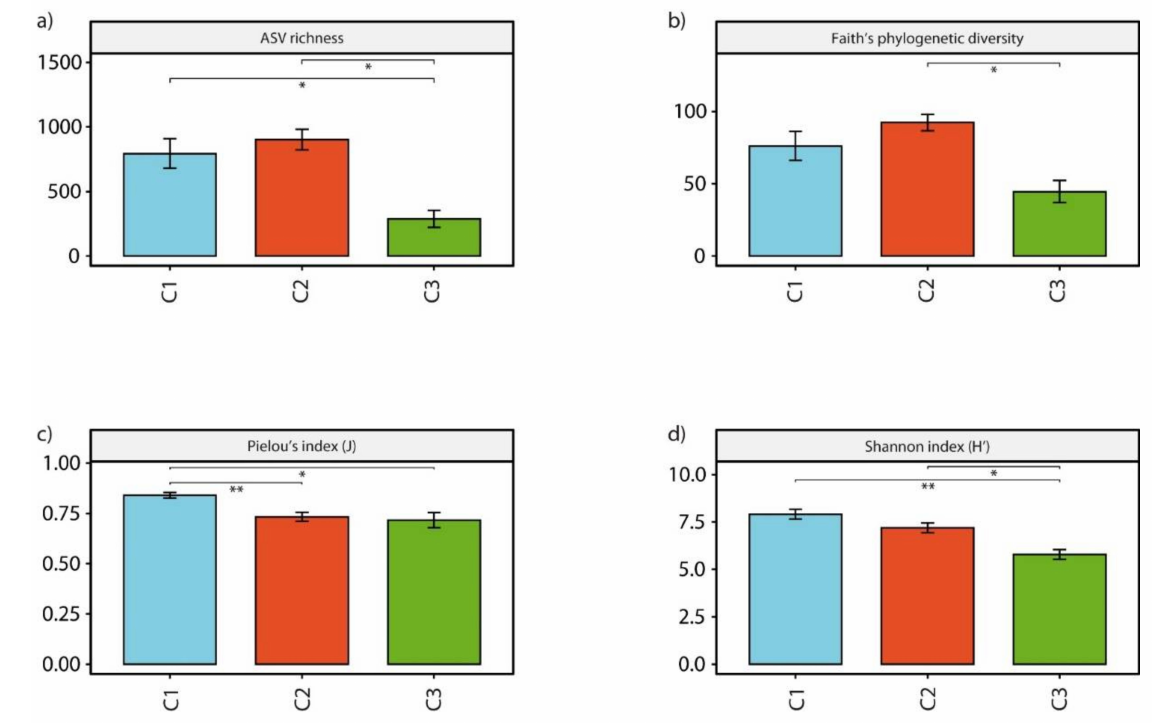
Figure 4. Impact of acidification on prokaryotic α -diversity. Histograms showing the average values for ASV richness ( a ), Faith’s phylogenetic diversity ( b ), Pielou’s index ( c ) and Shannon index ( d ) among the 3 clusters identified, with asterisks displaying significant differences between clusters (* for p -values < 0.05, ** for p -values < 0.01) and error bars computed on the standard error for each cluster.